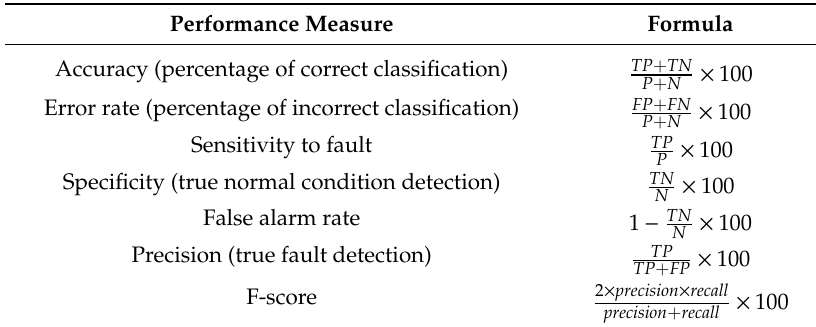
Table 2. Indicators used to evaluate the performance of leak detection